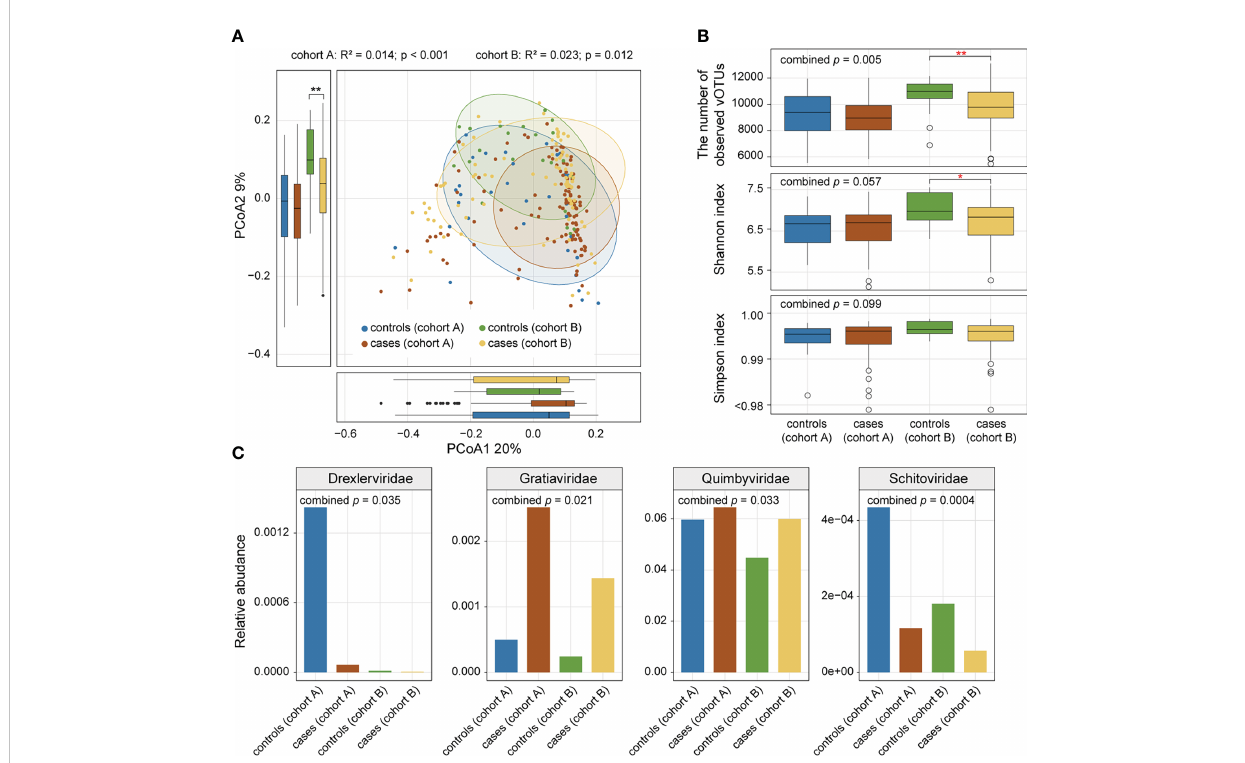
FIGURE 2 Comparison of gut viral diversity and composition between AS patients and healthy controls. (A) PCoA of Bray-Curtis distances of the gut virome at the vOTU level. Samples are shown at the fi rst and second principal coordinates (PCoA1 and PCoA2), and the ratio of variance contributed by these two PCoAs is shown. Ellipsoids represent a 95% con fi dence interval surrounding each group. The bottom and left boxplots show the sample scores in PCoA1 and PCoA2 (boxes show medians/quartiles; error bars extend to the most extreme values within 1.5 interquartile ranges). (B) Boxplot showing the number of observed vOTUs (upper panel), Shannon diversity index (middle panel), and Simpson diversity index (bottom panel) of the gut virome of all samples. Wilcoxon rank-sum test: *p<0.05; **p<0.01. (C) Bar plot showing relative abundances of differentially abundant viral families between patients and